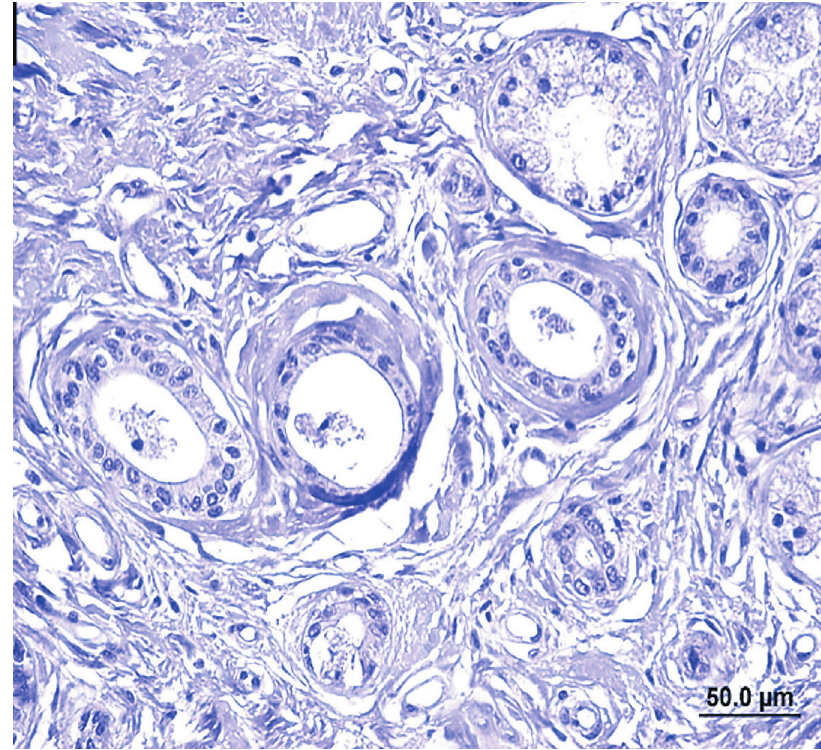
Figure 6- Absence of nuclei expression of Ki-67 in the duct-like structures (Group